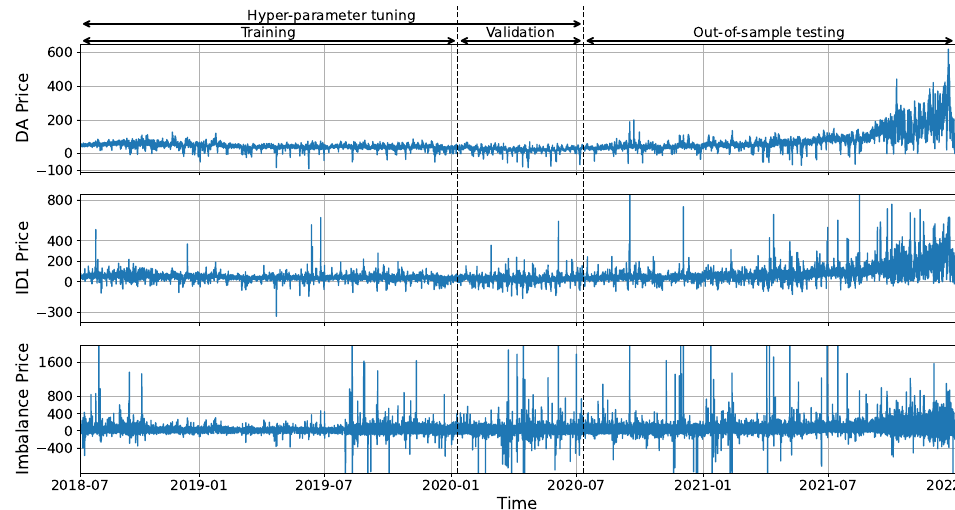
Figure 2. Time series plots of various electricity price data in